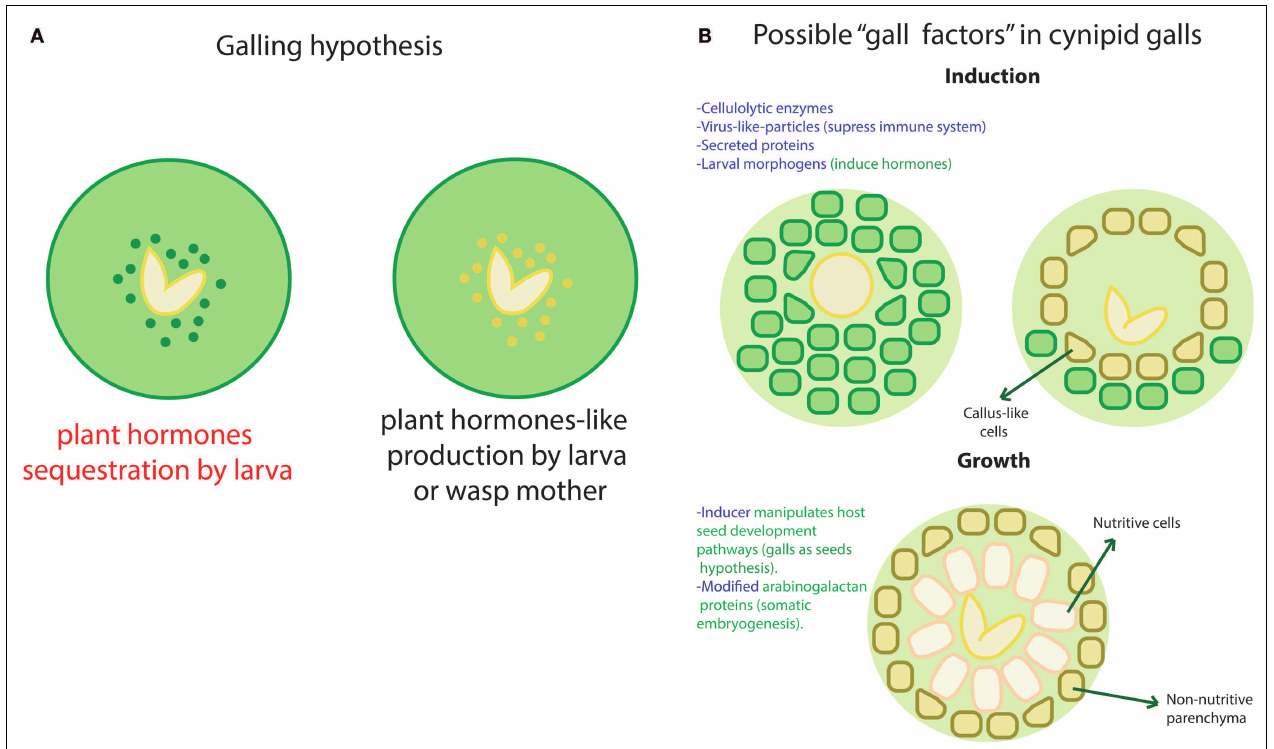
FIGURE 2 | Galling hypothesis . A few hypothesis about how galls take place and maintain in plants have been posed. This image intends to summarize most of them according to the exposed in Hearn (2014) and Tooker and Helms (2014). (A) Regarding hormones, two likely ways have been proposed to induce and maintain a gall. In the first one, the wasp larva could be sequestering hormones as in the left case (in red) or produce hormones-like metabolites that